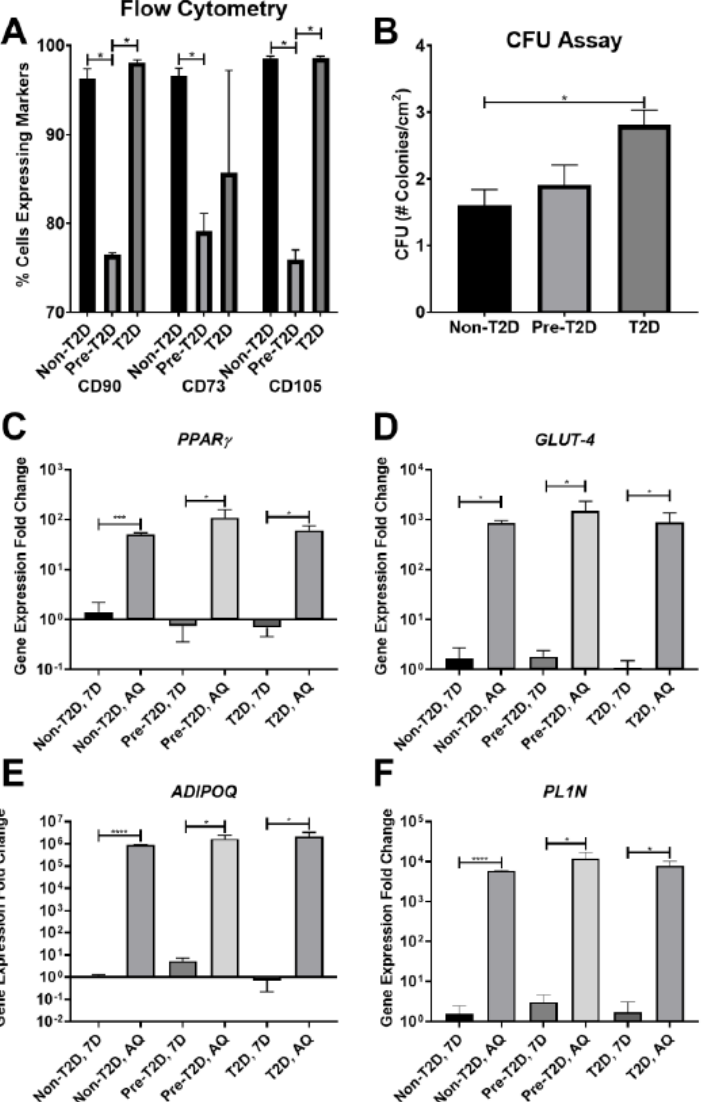
Figure 1. Decreased expression of CD90, CD73, and CD105 on Pre-T2D IPFP-ASCs. ( A ) Flow cytometry for CD90 and CD105 demonstrated decreased expression in Pre-T2D IPFP-ASCs compared to those from Non-T2D and T2D groups ( n = 3, * p < 0.05). ( B ) CFU assay illustrated increased self-renewal properties in T2D IPFP-ASCs compared to Non-T2D ( n = 3, * p < 0.05). ( C – F ) RT-qPCR for common adipokines in ASCs and adipocyte differentiated ASCs demonstrated no significant difference in adipogenic potential between Non-T2D, Pre-T2D, and T2D IPFP-ASCs ( n = 3, * p < 0.05, *** p < 0.001, **** p < 0.0001). Non-T2D IPFP ASCs 7-Day is the control Group set as 1. Non-T2D: IPFP- ASCs from donors without Type II diabetes mellitus, Pre-T2D: IPFP-ASCs from donors with pre-Type II diabetes mellitus, T2D: IPFP-ASCs from donors with type II diabetes mellitus, 7D: Confluent ASCs, AQ: Adipocyte Differentiated